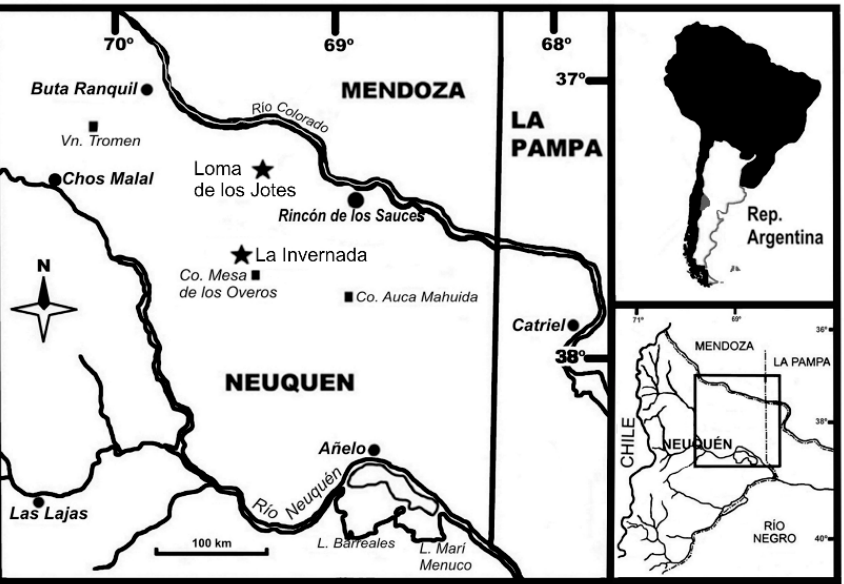
Figure 1. Map showing the location of La Invernada and Loma de los Jotes paleontological sites (Rincón de los Sauces city, Neuquén province, Argentina).